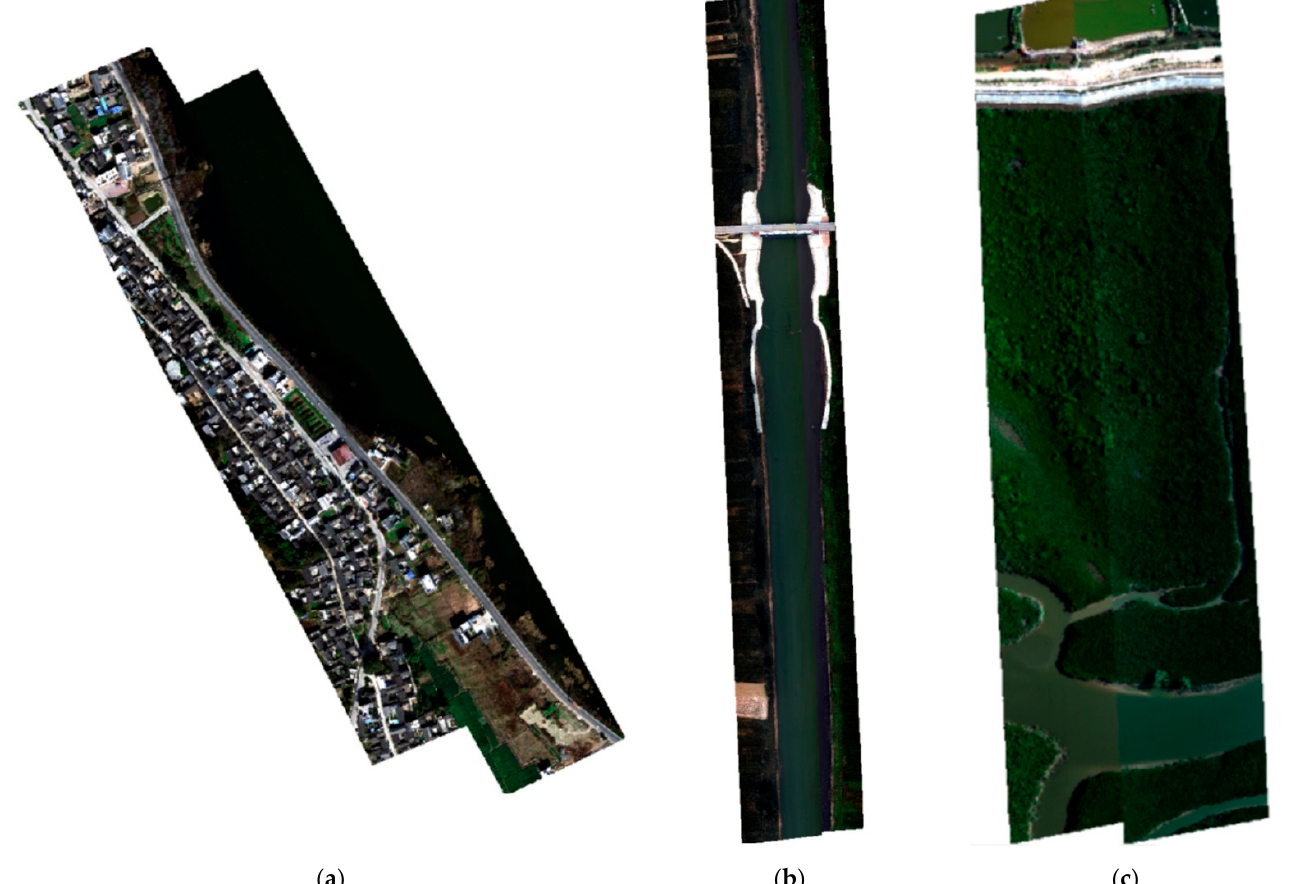
Figure 7. SIFT and RANSAC-based image registration results: ( a ) Urban scape; ( b ) River course; ( c ) Forest.